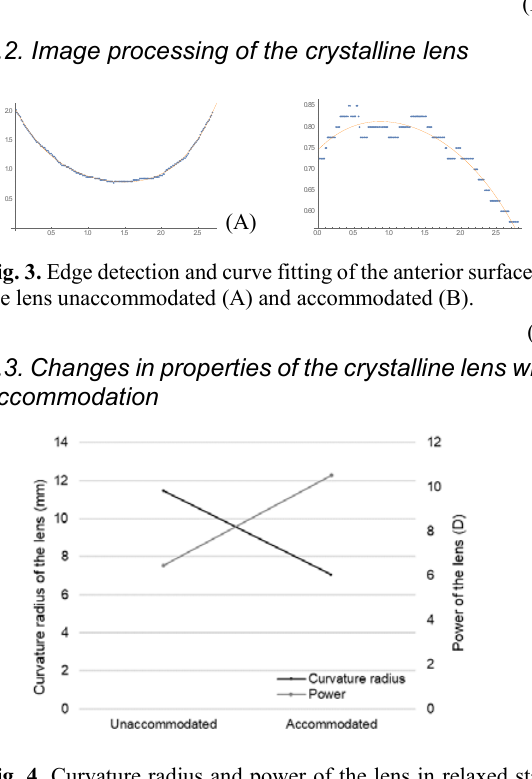
Fig. 4. Curvature radius and power of the lens in relaxed state and with an accommodative stimulus of 4.00